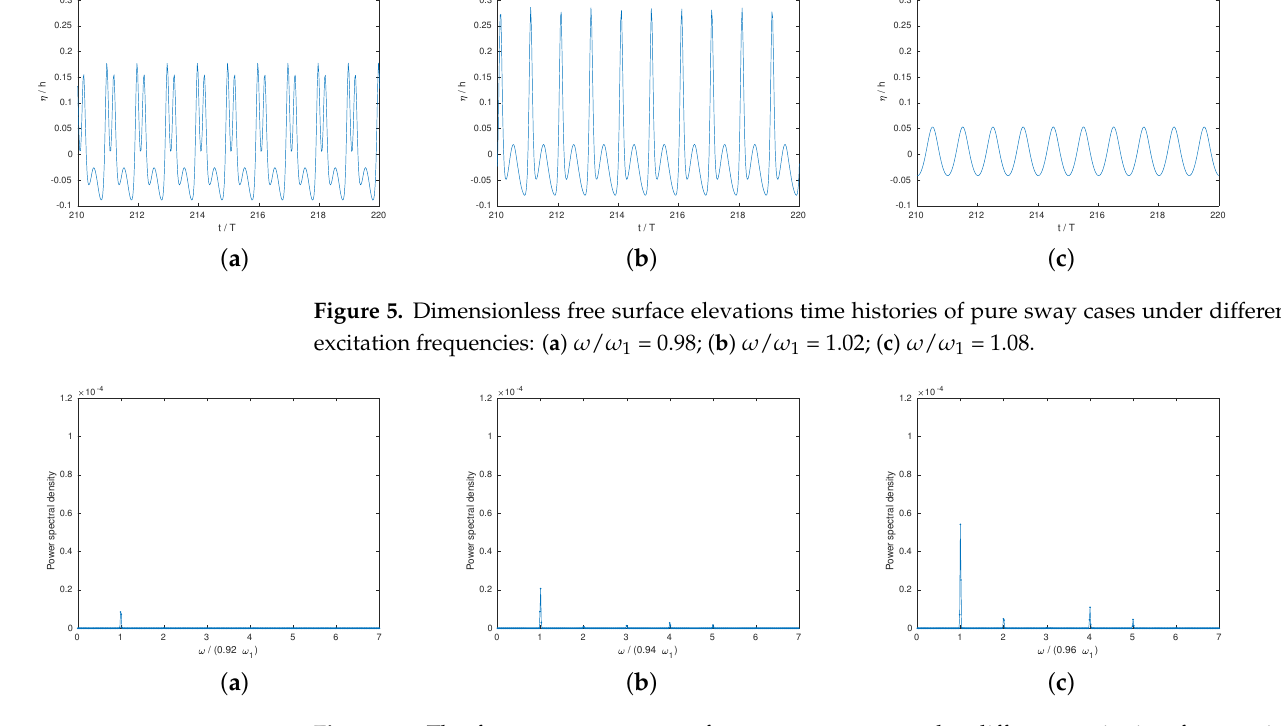
Figure 6. The frequency spectrum of pure sway cases under different excitation frequencies: ( a ) ω / ω 1 = 0.92; ( b ) ω / ω 1 = 0.94; ( c ) ω / ω 1 =